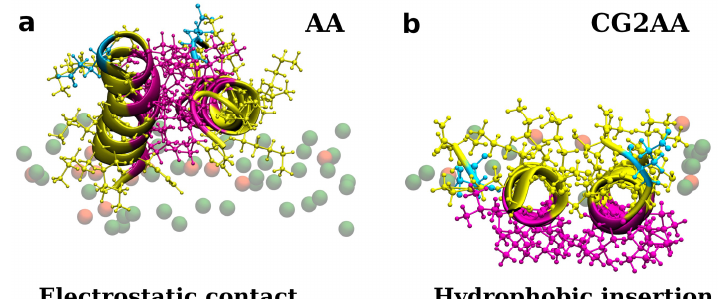
Figure 5. Representations of two adepantin-1 peptides interacting with Gram-negative bacterial membrane. Snapshot ( a ) is the AA-2 simulation results that show electrostatic bonding of charged residues with upper leaflet lipids. Snapshot ( b ) is the result of CG2AA simulation, depicting further steps in membrane-peptides interactions, where dimer is rotated placing hydrophobic residue in contact with the membrane hydrophobic core. Peptides are depicted as ribbons and spheres, with hydrophobic residues in magenta, polar and positively charged residues in yellow and negative Glu in cyan. The upper leaflet of the membrane is represented by beads for P atoms that are shown in green for POPE lipids. For clarity, other atoms and molecules of the membranes, as well as water molecules and ions, are